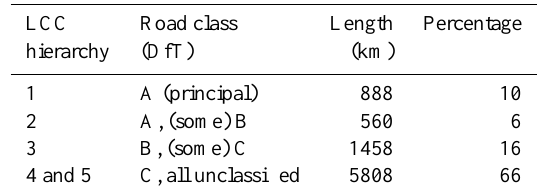
Table 2. Road classification in terms of length and percentage of network in